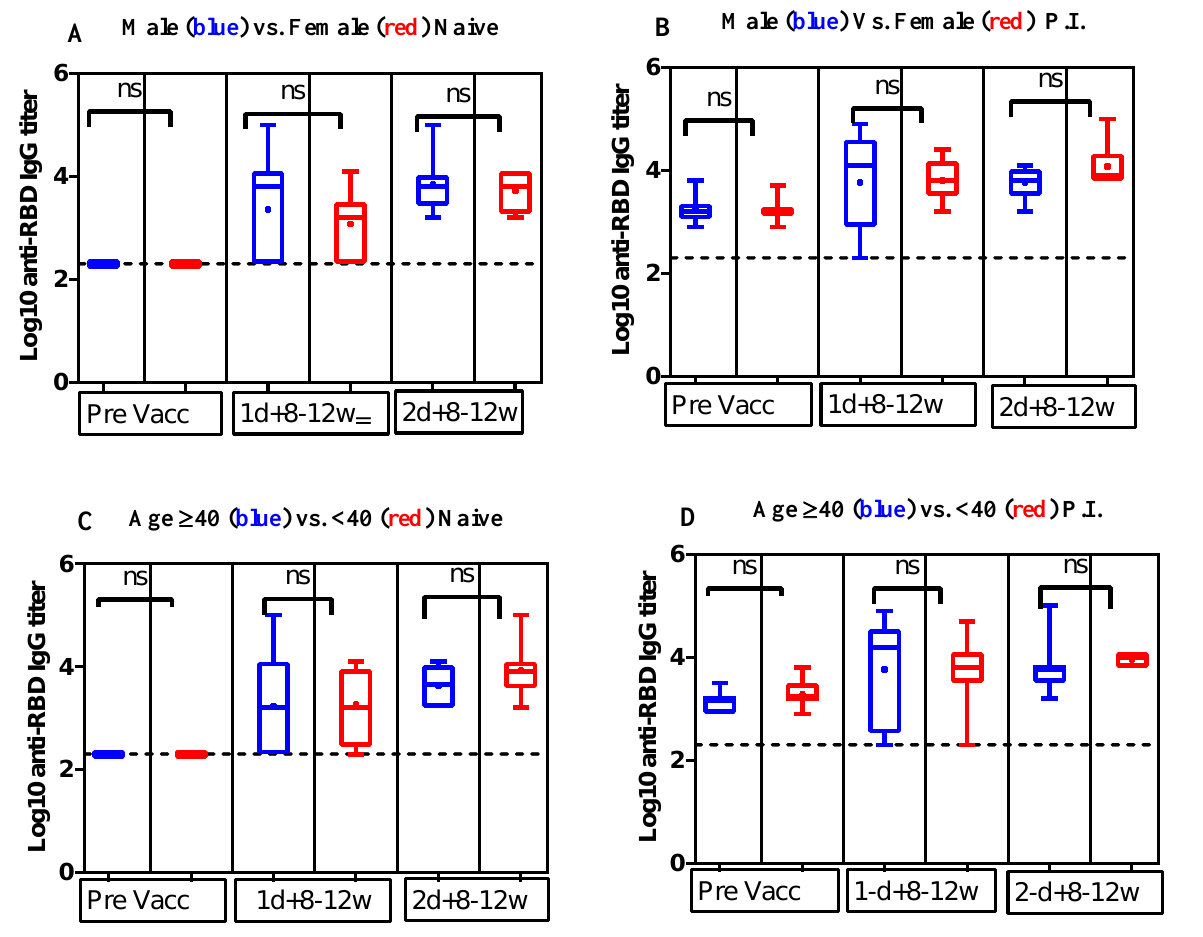
Figure 3. Antibody response by age and sex of naïve and previously infected (P.I.) participants following vaccination. Antibody response comparison of ( A ) naïve and ( B ) P.I. participants by age: 40–59 (blue dots) versus 21–39 years (red dots); antibody response comparison of ( C ) naïve and ( D ) P.I. participants by sex: male (blue dots) versus female (red dots). Pre Vacc = baseline